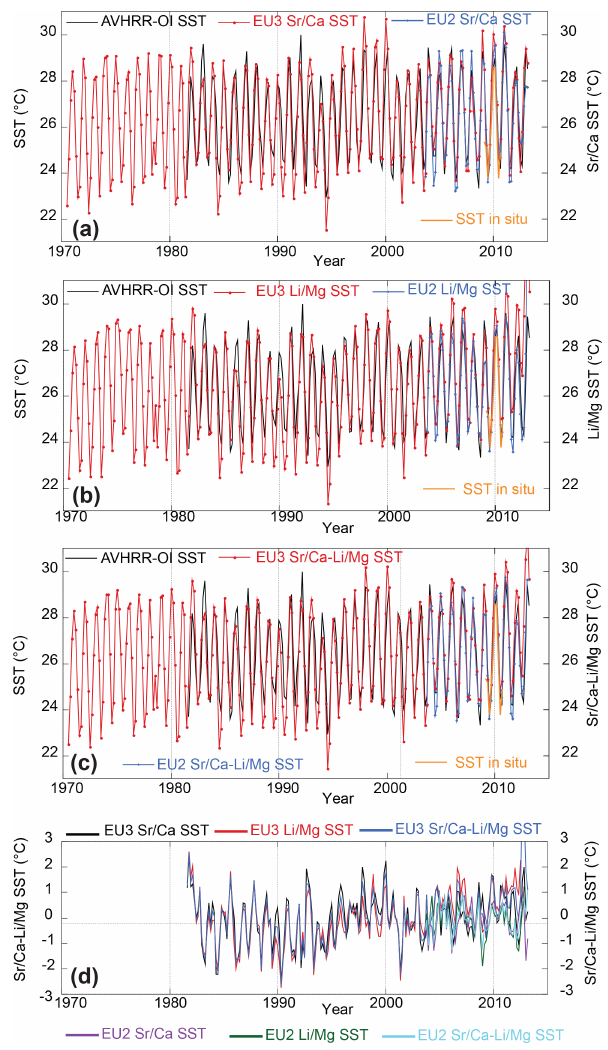
Figure 6. Absolute SST reconstructions for cores EU3 (red) and EU2 (blue) with SST residuals based on the calibration period 1981 to 2012 for (a) Sr / Ca SST, (b) Li / Mg SST, and (c) their combination in comparison to AVHRR-OISSTv2 (Banzon et al., 2016; black) and in situ SST (orange; 2009–2010). (d) Residuals for Sr / Ca SST, Li / Mg SST, and their combination for cores EU2 and EU3 with respect to the AVHRR-OISSTv2 data (Banzon et al.,